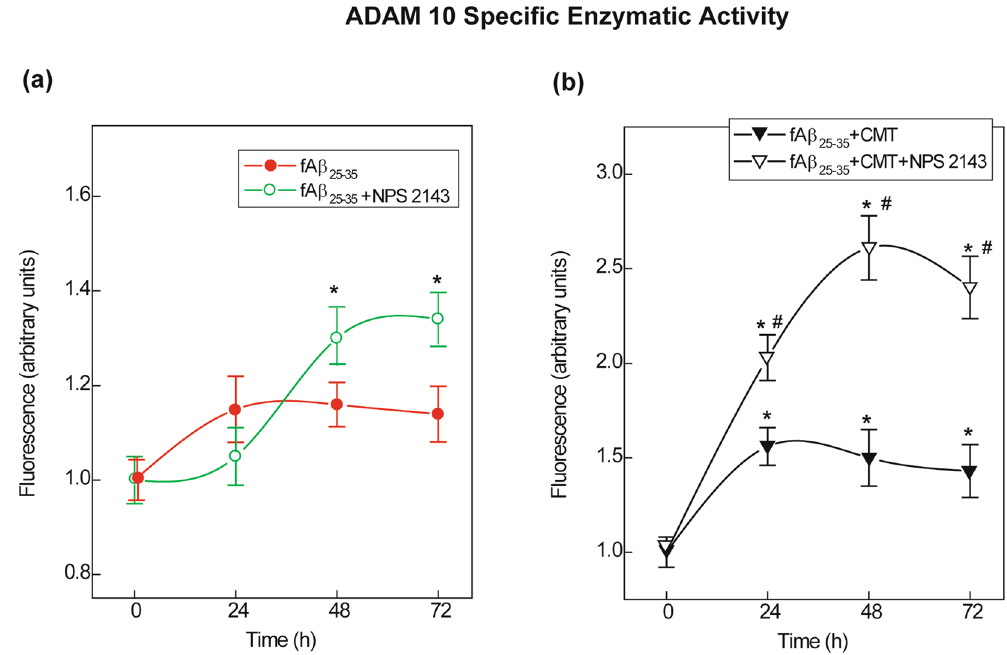
Figure 5. ADAM10 specific enzymatic activity alterations in human astrocyte protein lysates. (a ) Changes in ADAM10 specific activity after an exposure to fA β 25–35 ± NPS 2143. (b ) Alterations in ADAM10 specific activity increases after treatment with fA β 25–35 + CMT ± NPS 2143. The specific activities in A and B were assayed as described in the Methods section. Points on the curves are means ± SEM of 3 independent experiments with 0-h values normalized as 1.0. One-way ANOVA analysis of : ( i ) fA β 25–35 ± NPS2143 data set: F = 7.923, P < 0.001; ( ii ) fA β 25–35 + CMT ± NPS 2143 data set: F = 74.248, P < 0.001; Bonferroni t-test: comparisons of each treated group versus 0-h (controls): * P < 0.05; pair-wise comparisons of corresponding treatments ± NPS 2143 at each time point: # P <